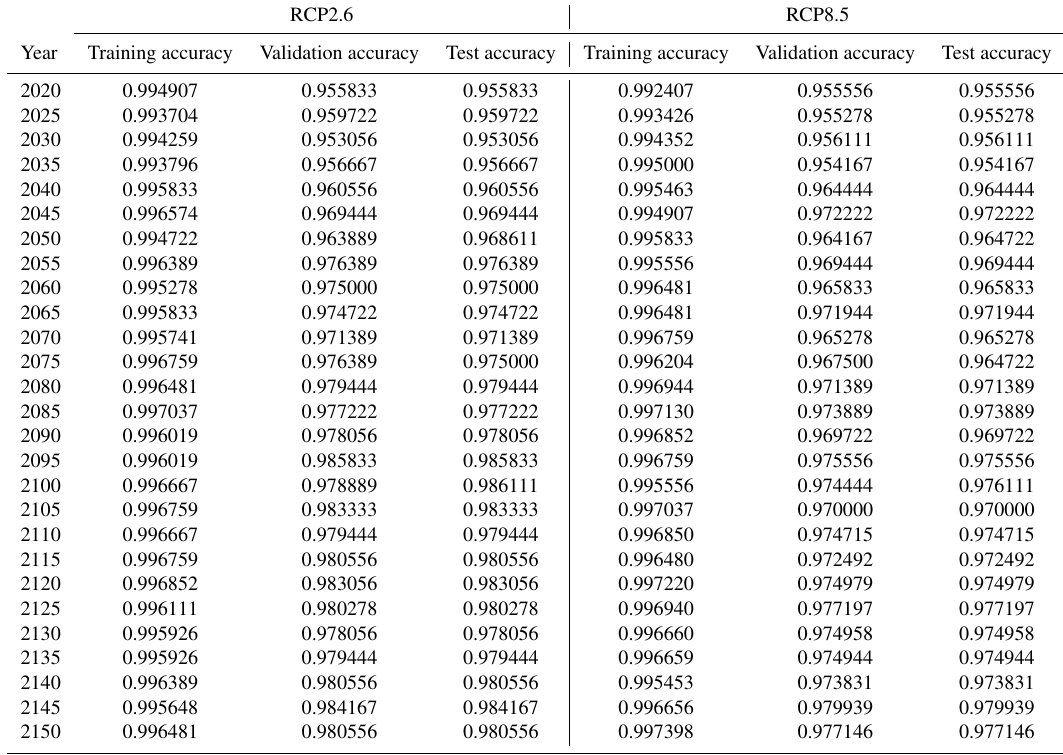
Table A2. Random forests’ accuracy on the training, validation, and testing